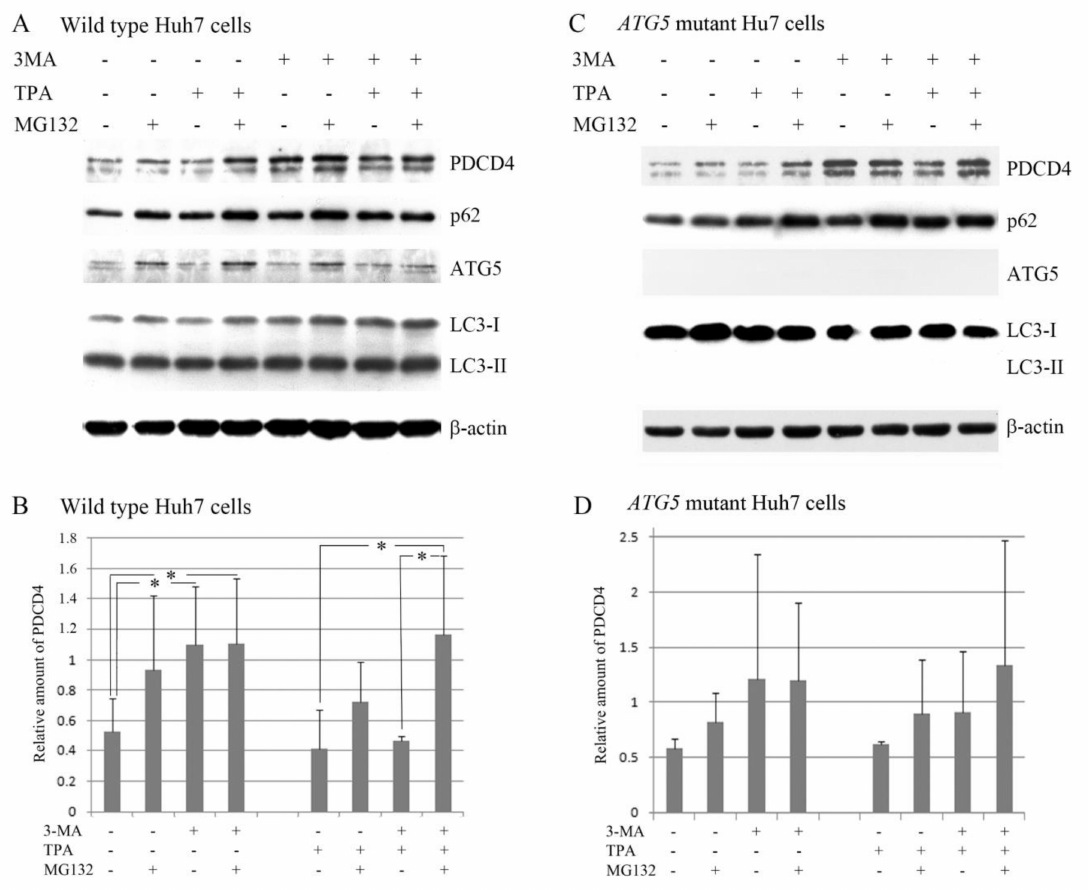
Figure 5. The PDCD4 levels were upregulated synergistically by 3-MA and MG132 in the wild ( A , B ) and ATG5 mutant-16 ( C , D ) Huh7 cells. (A) After culturing for 4 days, Huh7 cells were treated with or without 5 mM 3-MA in the presence or absence of 50 µ M TPA (12- O -tetradecanoylphorbol-13-acetate) and / or 20 µ M MG132. TPA and MG132 were added to the culture at 1.5 h after the addition of 3-MA, and the cells were further cultured for another 4 h. Western blotting analyses were performed using antibodies against the components indicated in the figure. In this experiment, the mouse